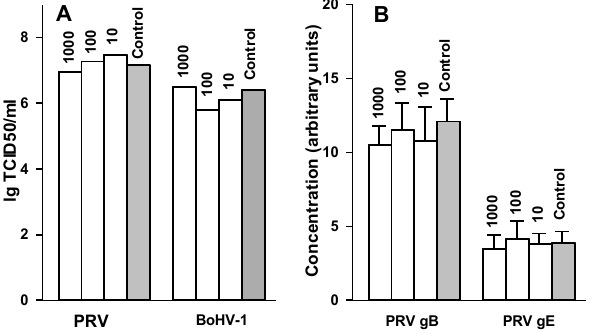
Figure 6. Effects of 2,5-DHBA–gelatin conjugate on production of infectious PRV and BoHV-1 particles ( A ) and expression of PRV glycoproteins B and E ( B ). The viruses were adsorbed on appropriate cells at 4 °C, incubated for 1 h at 37 °C to allow the virus to penetrate cells, and unpenetrating viruses were inactivated. The cells were incubated in DMEM containing different concentrations of 2,5-DHBA–gelatin for 10 h at 37 °C. Then, virus titres ( A ) and relative concentrations of PRV glycoproteins B and E ( B ) were determined in cell lysates. The relative concentrations of PRV gB and gE ( B ) are presented in arbitrary units as the mean ˘ SD of four repetitions. 2,5-DHBA–gelatin concentrations ( µ g/mL) are indicated above bars.